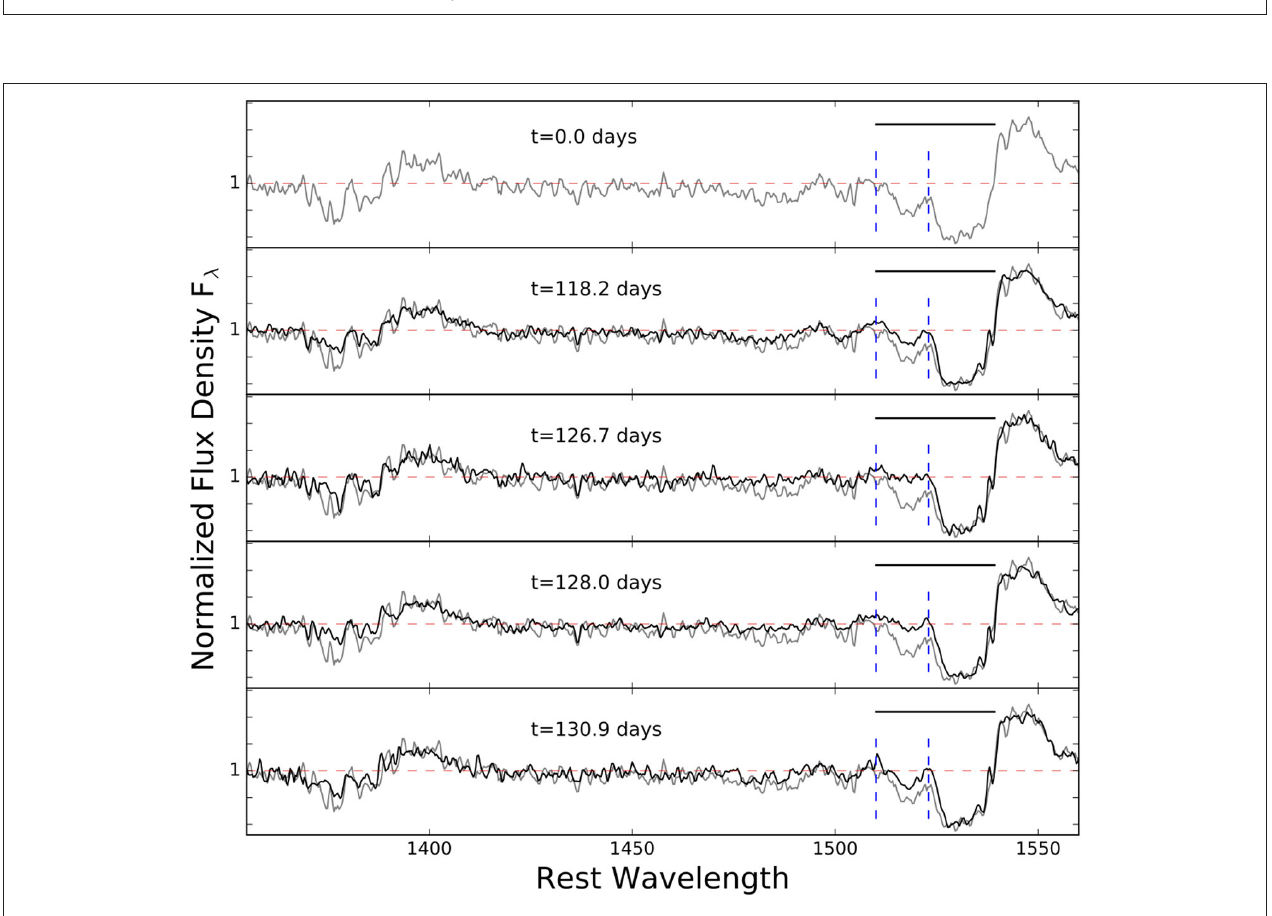
FIGURE 1 | C IV and Si IV emission lines and their BAL regions in the mean spectrum calculated from 32 continuum normalized observations of J1419. The three identified C IV BALs (A, B, and C) and one Si IV BAL are shown in gray areas. The dashed vertical line on C A separates two main components of the BAL complex. The dashed horizontal line indicates normalized flux density of 1.0.